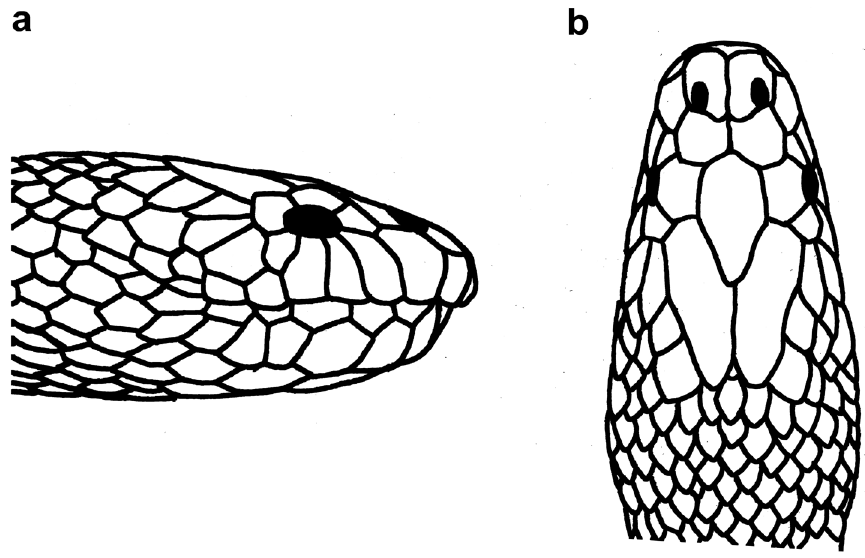
Figure 18. Head of Hydrophis cyanocinctus : a lateral view b dorsal view.